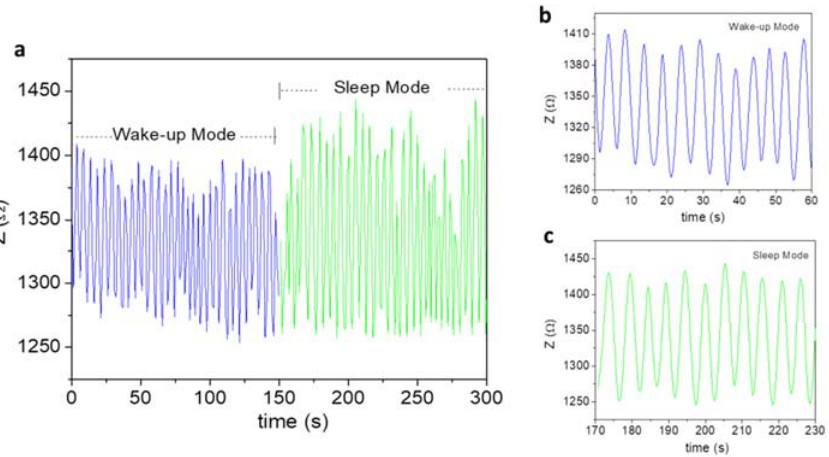
Figure 7. ( a ) Breathing patterns of Subject 1 in both wake and sleep modes. An obvious transition from the wake to sleep mode was observed. ( b , c ) show the wake and sleep breathing patterns over 1 min.